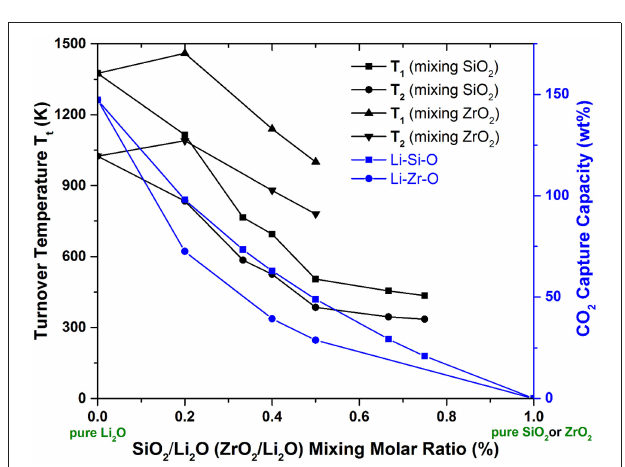
FIGURE 5 | The shifts of MgO turnover temperatures by adding several oxides (carbonates) with a molar ratio of 1:1. T 1 are the turnover temperatures under pre-combustion conditions with CO 2 partial pressure of 20 bars, while T 2 are the turnover temperatures under post-combustion conditions with CO 2 partial pressure of 0.1